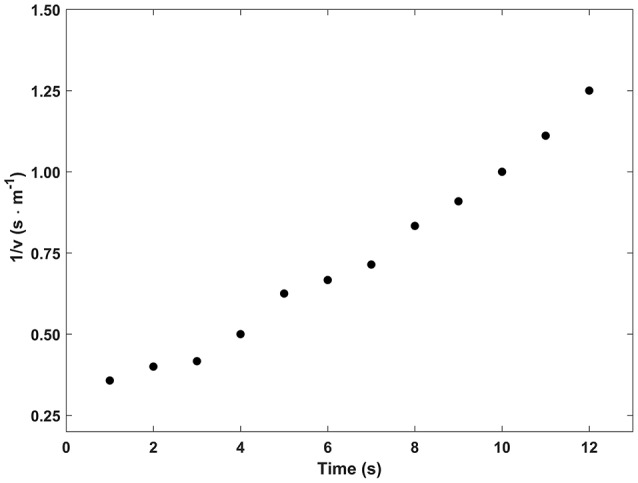
The reciprocal of the decreasing speed (υ) obtained during a typical experiment of spontaneous deceleration plotted as a function of the time.